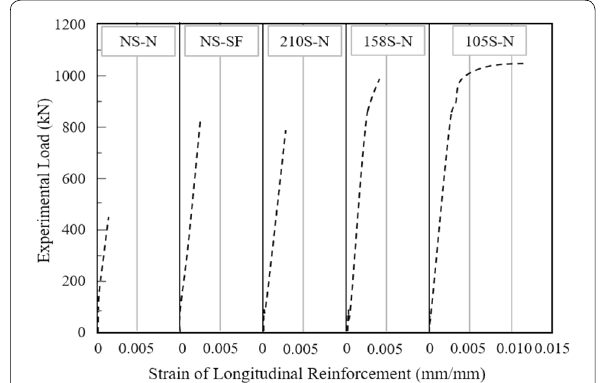
Fig. 7 Experimental load‑longitudinal steel strain